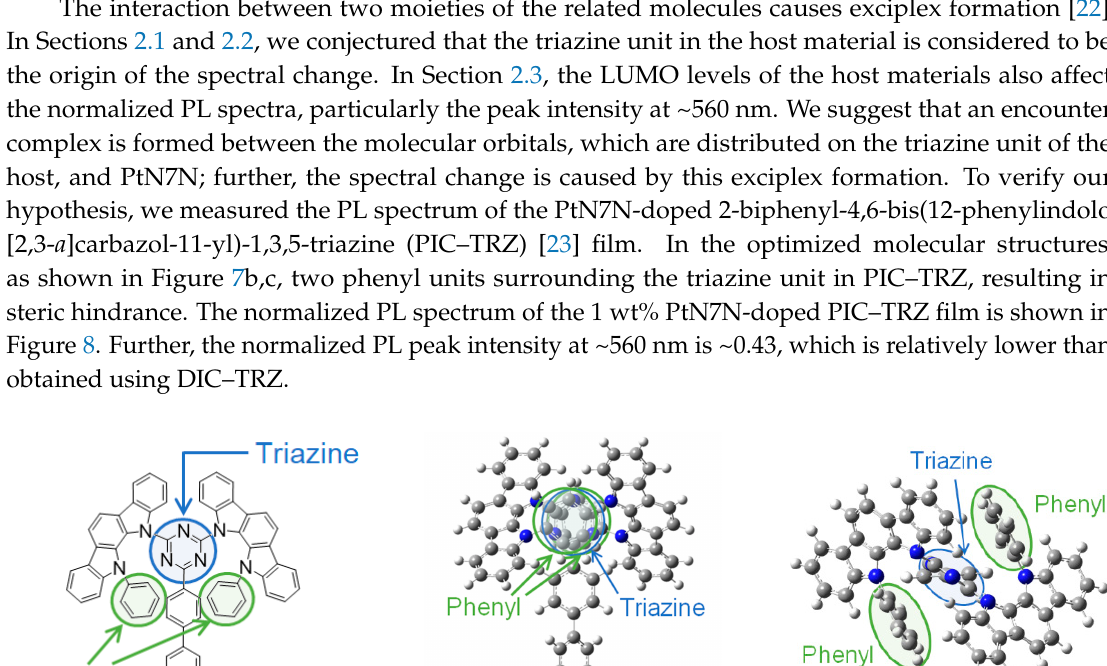
Figure 8. Normalized PL spectra of PtN7N in PIC–TRZ and DIC–TRZ. 3. Materials and Methods 3.1. Fabrication of OLEDs The OLEDs were fabricated on the glass substrates coated with a 100 nm thick indium tin oxide layer as the anode. Before fabricating the organic layers, the substrate was cleaned using ultra- purified water and organic solvents and was treated with UV-ozone in ambient conditions. To reduce the possibility of electrical shorts within the device, a 30 nm thick layer of Clevios HIL 1.3 N (supplied by Heraeus Holding GmbH, Hanau, Germany) was spin coated onto the substrate. Futher, the organic layers were sequentially deposited onto the substrate without breaking the vacuum at ~10 − 5 Pa. The film structures of the PHOLEDs using CBP and DIC–TRZ were obtained as follows: α -NPD (20 nm)/4DBFP3Q [24] (10 nm)/host:PtN7N (6 wt%, 25nm)/TPBi (35 nm), where α - NPD represents 4,4 ′ -bis[ N -(1-naphthyl)- N -phenyl-amino]biphenyl, 4DBFP3Q represents N 3, N 3 ′′′ - bis(dibenzo[ b , d ] furan-4-yl)- N 3, N 3 ′′′ -diphenyl-[1,1 ′ :2 ′ ,1 ″ :2 ″ ,1 ′′′ -quaterphenyl]-3,3 ′′′ -diamine and TPBi represents 1,3,5-tris( N -phenylbenzimidazol-2-yl)benzene. After the formation of the organic layers, a 0.8 nm thick LiF layer and a 100 nm thick Al layer were deposited that served as cathode. The devices were further encapsulated using a UV-epoxy resin and a glass cover in a nitrogen atmosphere. 3.2. Photoluminescence Measurement The 50 nm thick organic films were fabricated on clean quartz glass substrates using thermal evaporation. Further, the PL spectra and PLQY of the organic films were measured using a PLQY